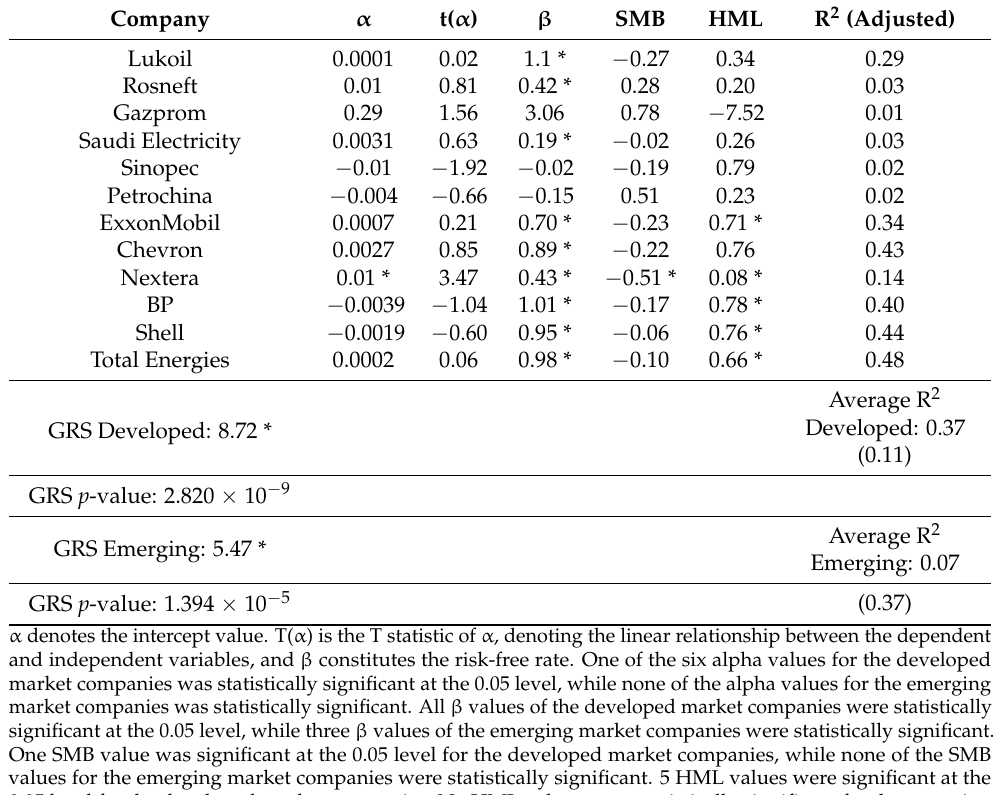
Table 1. Fama-French Three-Factor Regression Results for Leading Energy Companies, * p < 0.05; standard deviation on mean values in